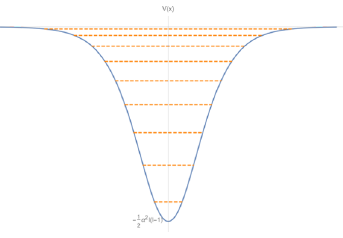
Figure 15. The cigar quantum mechanics